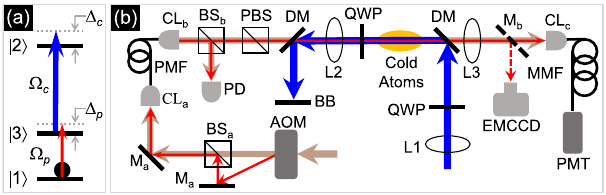
arrowed lines indicate the optical paths of the coupling, probe, and AOM ’ s zeroth-order beams,